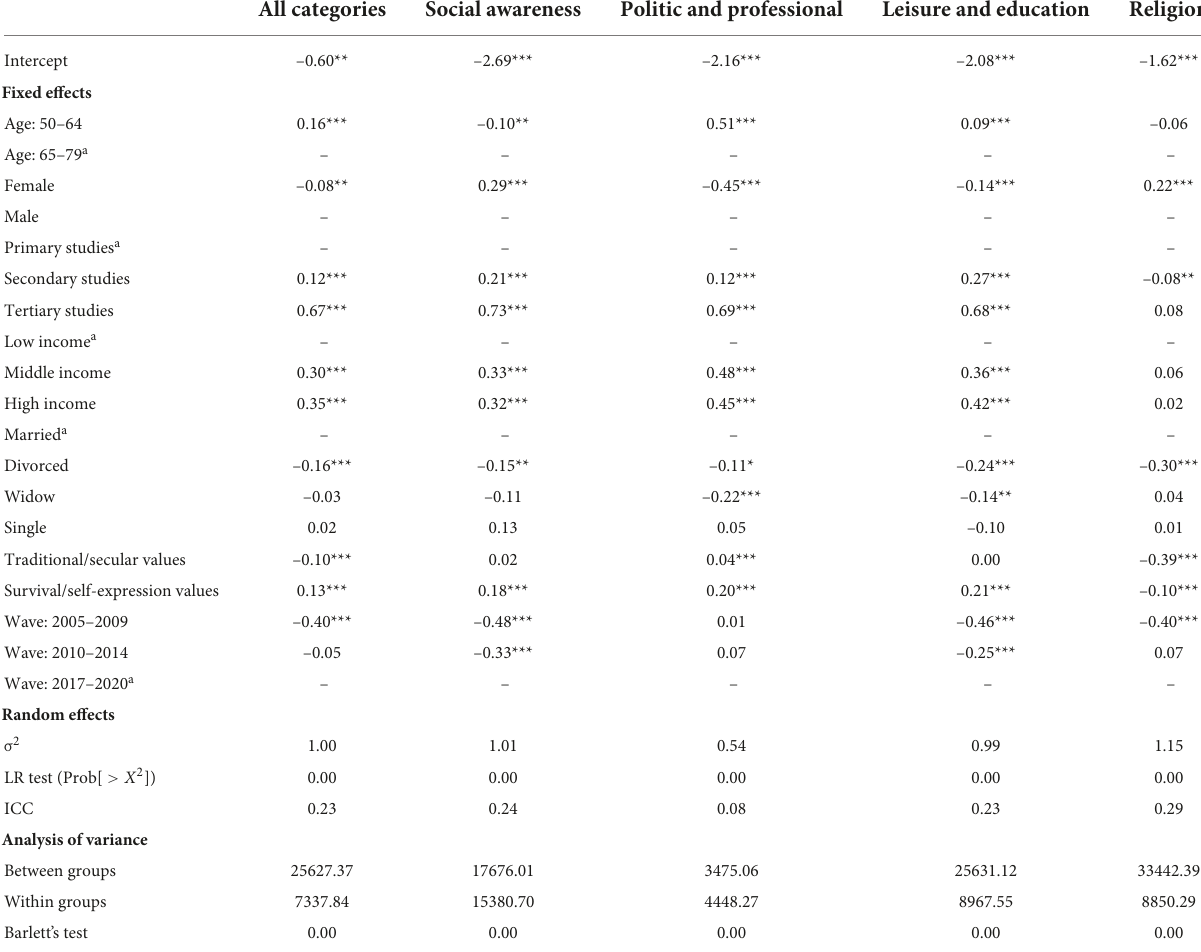
TABLE 2 Estimations of individual-level variables on volunteering: Model